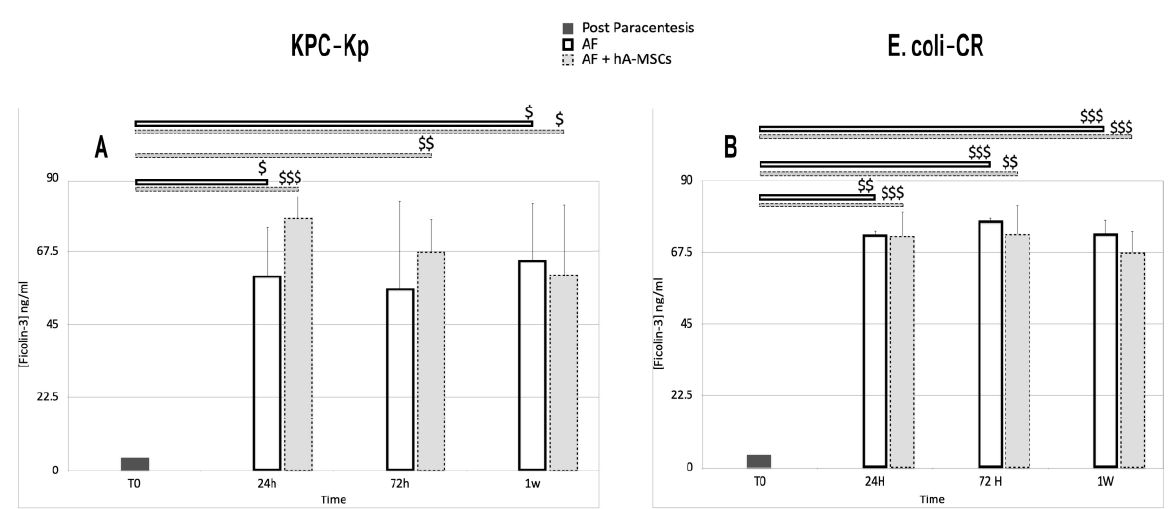
Figure 8. Ficolin-3 levels assessed using ELISA during AF infection with KPC-Kp ( A ) and E. coli-CR ( B ) cultured, with and without hA-MSCs, for 24 h, 72 h, and 1 week. Statistical analysis was done by comparison of results with T0 initial data ($). The data obtained showed a higher quantity of ficolin 3 at all time points, with respect to T0, for both types of infection. In particular, the presence of KPC-Kp determined a more relevant significance at 24 and 72 h in the presence of hA-MSCs (respectively, p < 0.001, $$$ and p < 0.01, $$) which decreased up to 1 week ( p < 0.05, $). The absence of hA-MSCs resulted in a lower significance only at 24 h and 1 week ( p < 0.05, $). ( B ) The E. coli-CR infection does not show a substantial difference in terms of ficolin 3 quantified in the two types of samples